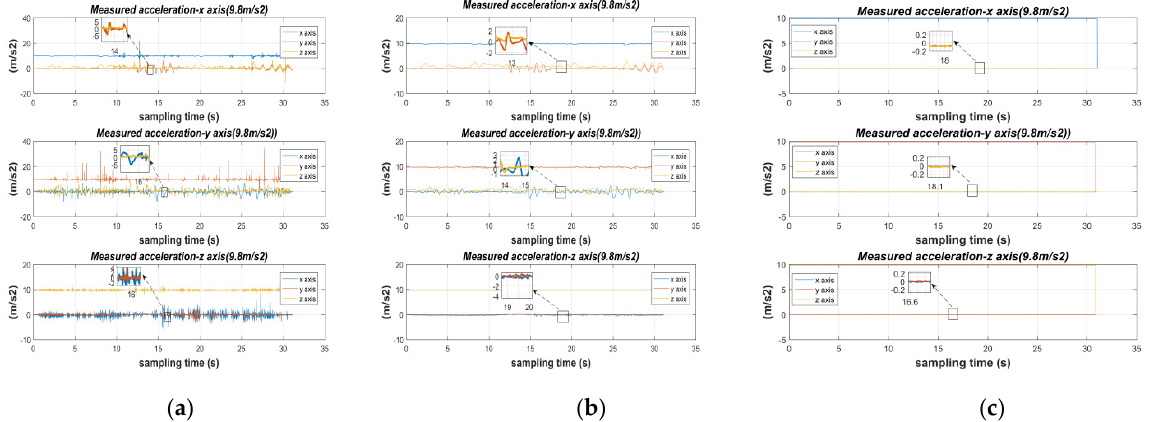
Figure 9. MEMS0 accelerometer in dynamic conditions: ( a ) raw sensor; ( b ) LM-calibrated sensor; ( c ) fused calibrated sensing. Table 9. Comparison of MEMS0 accelerometer parameters under dynamic conditions.